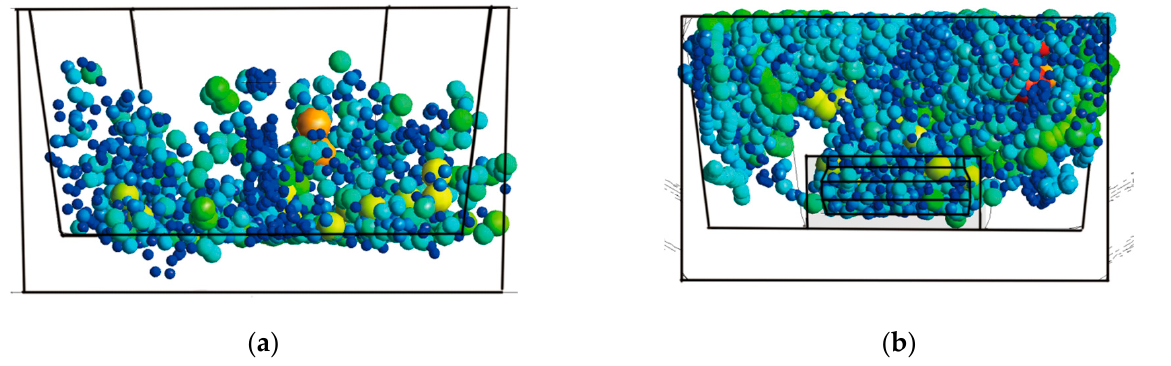
Figure 14. The influence of IRS structure on the trajectory of inclusions in the T-shaped area. ( a ) A 0 B 0 T = 15 s; ( b ) A 2 B 1 T = 30 s.